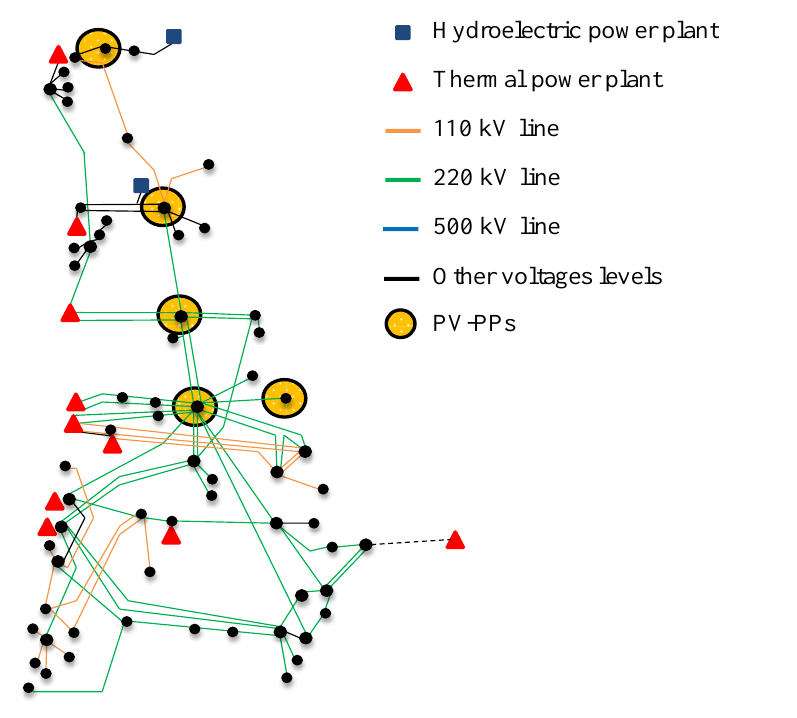
Figure 4. Simplified diagram of the Northern Interconnected System (NIS) of